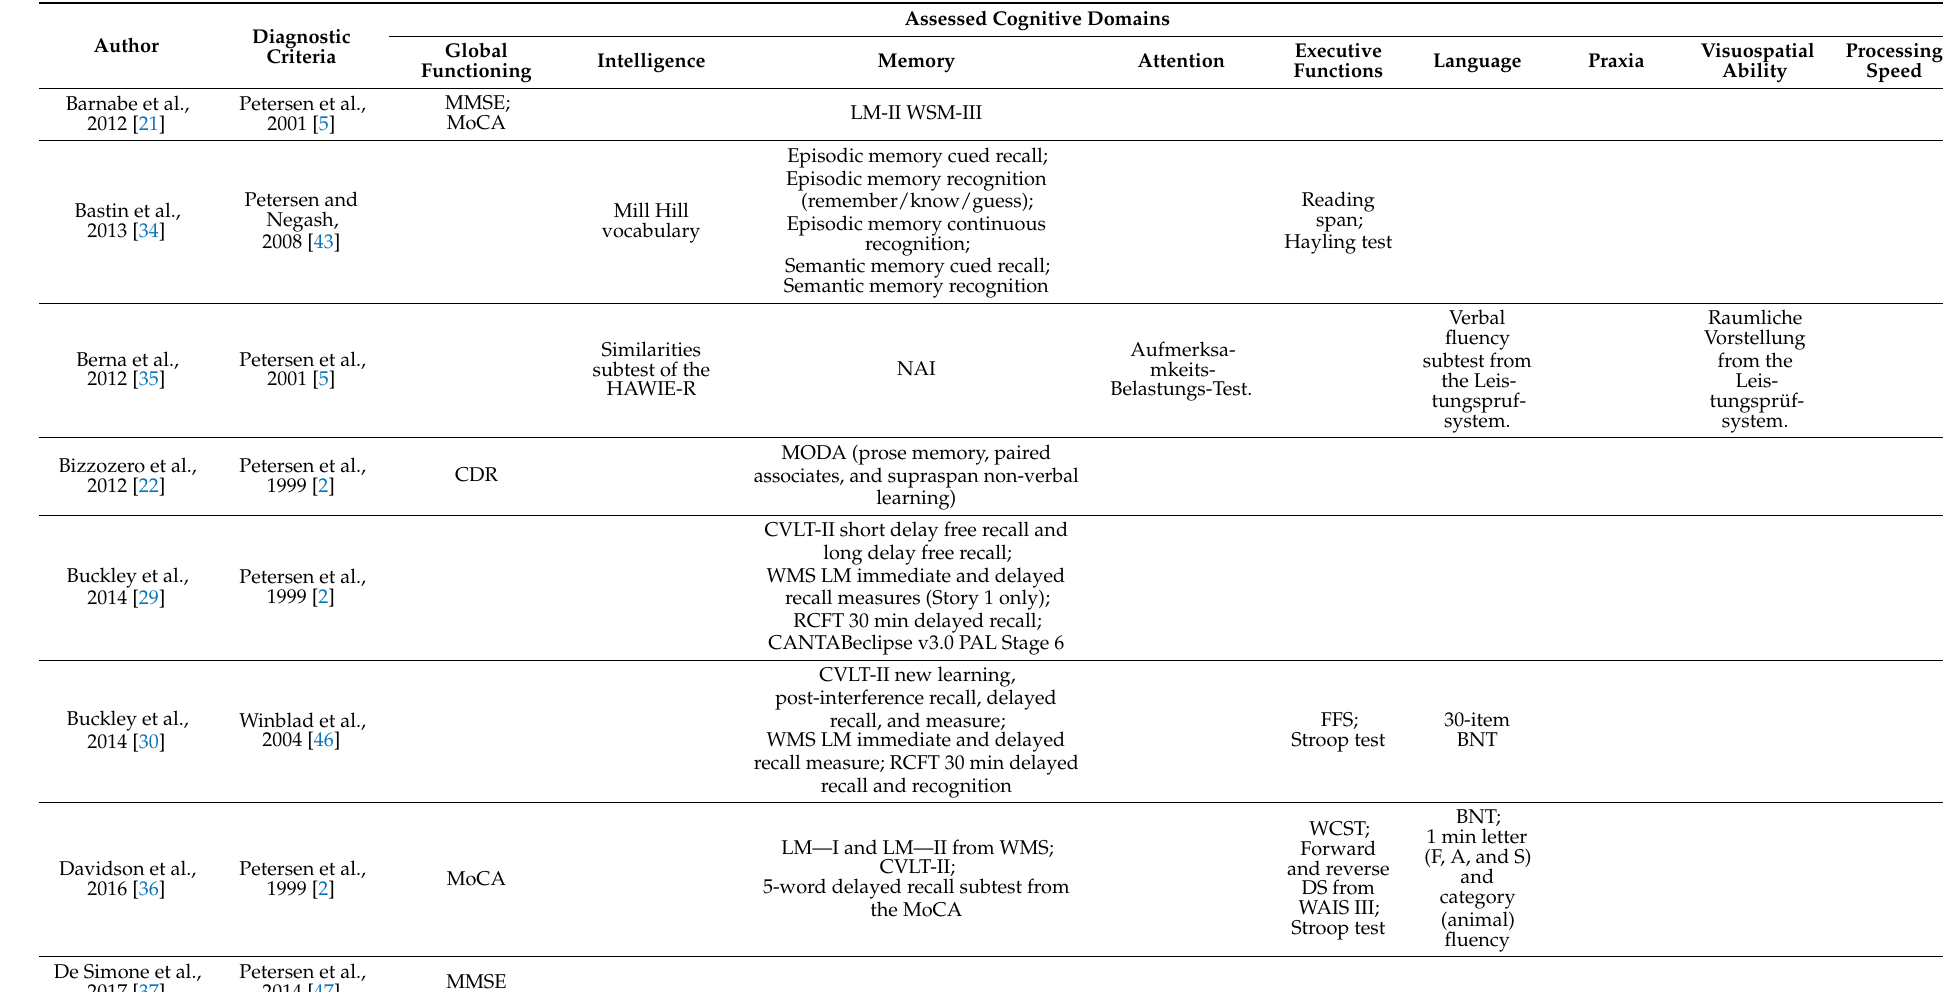
Table 5. Assessed cognitive domains and neuropsychological tests for MCI